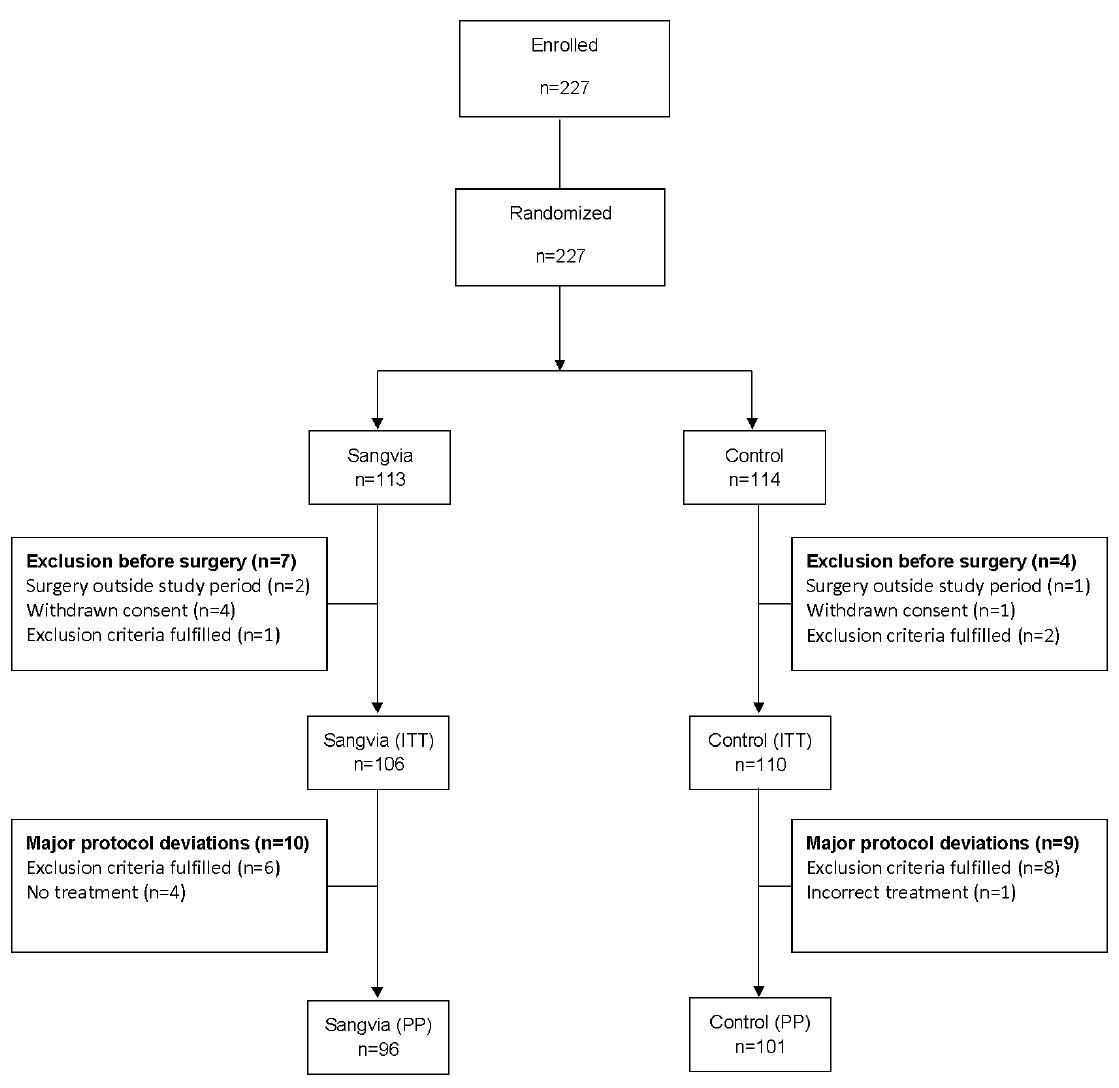
Figure 1. Study patient flow and definition of analysis sets.